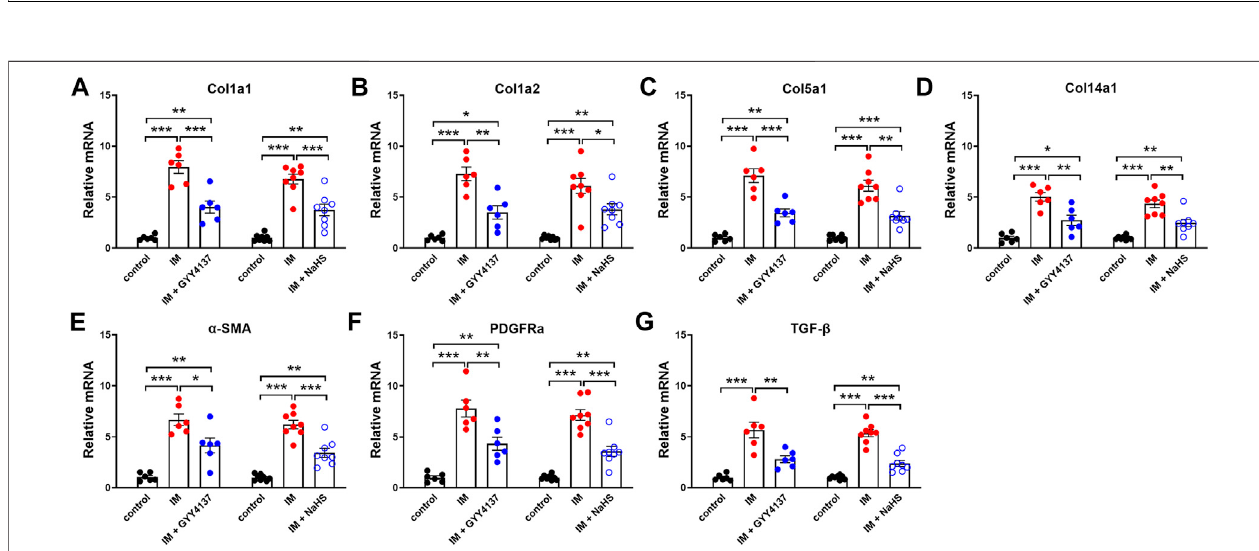
FIGURE4| H2S donorsdownregulatetheIM-induced mNRAexpressions oftissue fi brosisbiomarkersinskeletalmuscles.MiceweresubjectedtoIMandtreated withGYY4137(50 μ g/kg/d,ip,n=6),orNaHS(1.12 mg/kg,twiceaday,ip,n=8)for2 weeks.ThecontrolandIMgroupsreceivedidenticaldosesofsalinefor2weeks. (A-G) showedmRNAexpressionsoftissue fi brosisbiomarkersincludingCol1a1 (A) ,Col1a2 (B) ,Col5a1 (C) ,Col14a1 (D) , α -SMA (E) ,PDGFRa (F) ,andTGF- β (G) inTA muscles. Data represent means ± SEM. * p < 0.05, ** p < 0.01, *** p < 0.001.